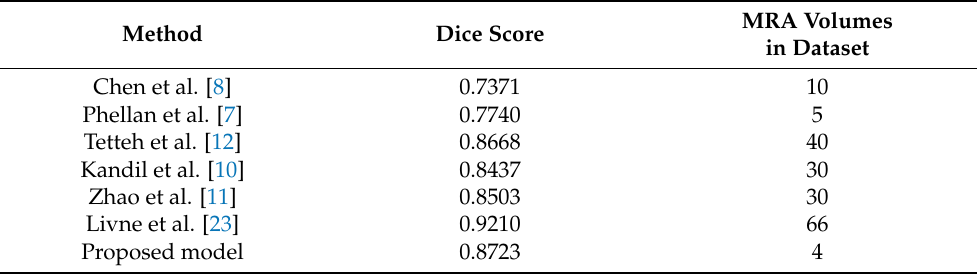
Table 3. Dice score and data availability for different vessel segmentation in MRA images alongside the proposed